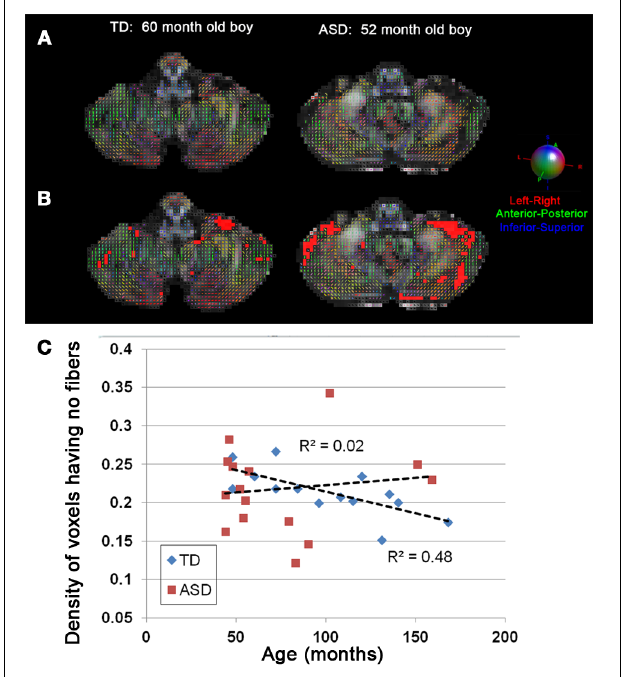
FIGURE 4 | (A) Directions of stick compartments obtained by the ICA + BSM in two boys, (left) TD and (right) ASD. Each colored bar represents primary orientation of individual axonal bundle within the voxel of cerebellar white matter. (B) Voxels having no stick compartments were denoted by red boxes. (C) The density of cerebellar voxels having no stick compartments was evaluated in individual children in both the TD and ASD groups. To avoid a confound of size of the cerebellum, the total number of voxels having no stick compartments was normalized by total number of voxels in entire cerebellum which yields the density of voxels having no stick compartments. The TD group shows a significant age-related decrease in the density of voxels having no stick compartments ( R 2 = 0 . 48, p = 0 . 0044), while the ASD group shows no age related decrease ( R 2 = 0 . 02, p = 0 .